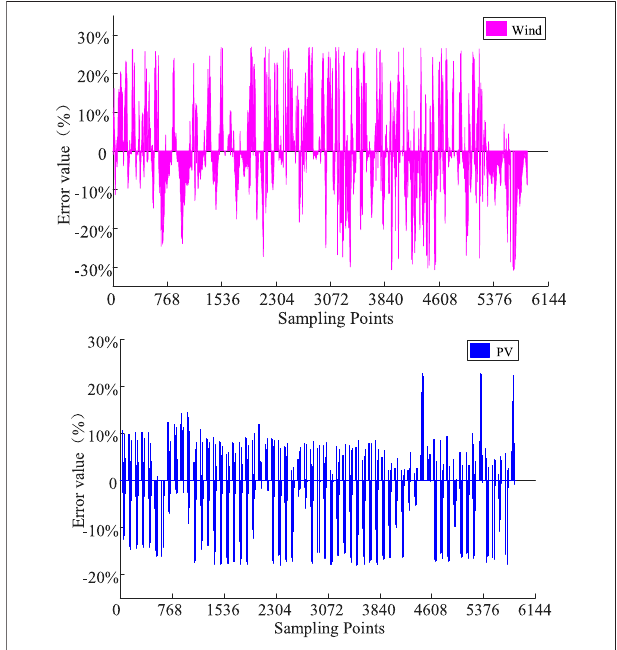
FIGURE 1 | Forecast error values for wind and